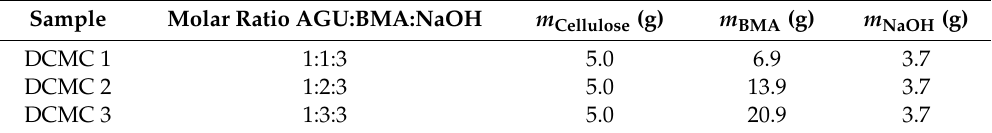
Table 1. Conditions for dicarboxymethyl cellulose (DCMC) polymers production.